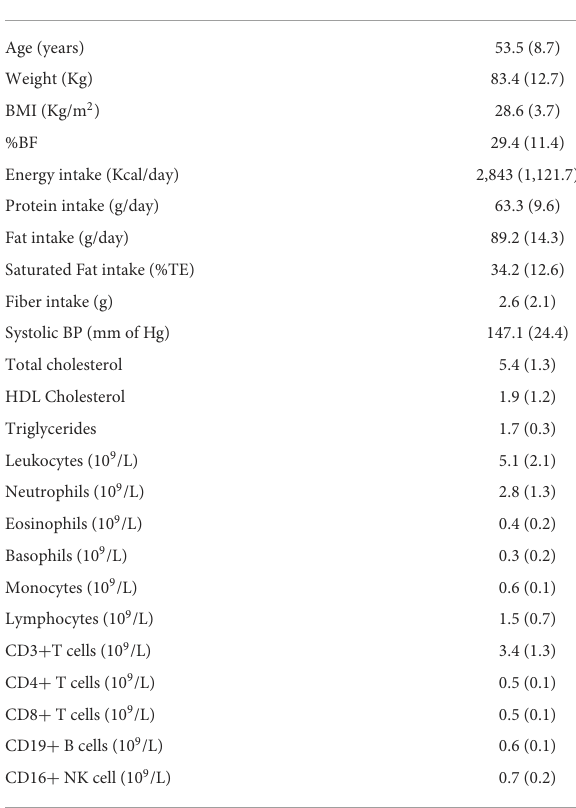
TABLE 1 Baseline characteristics of the study participants ( n =